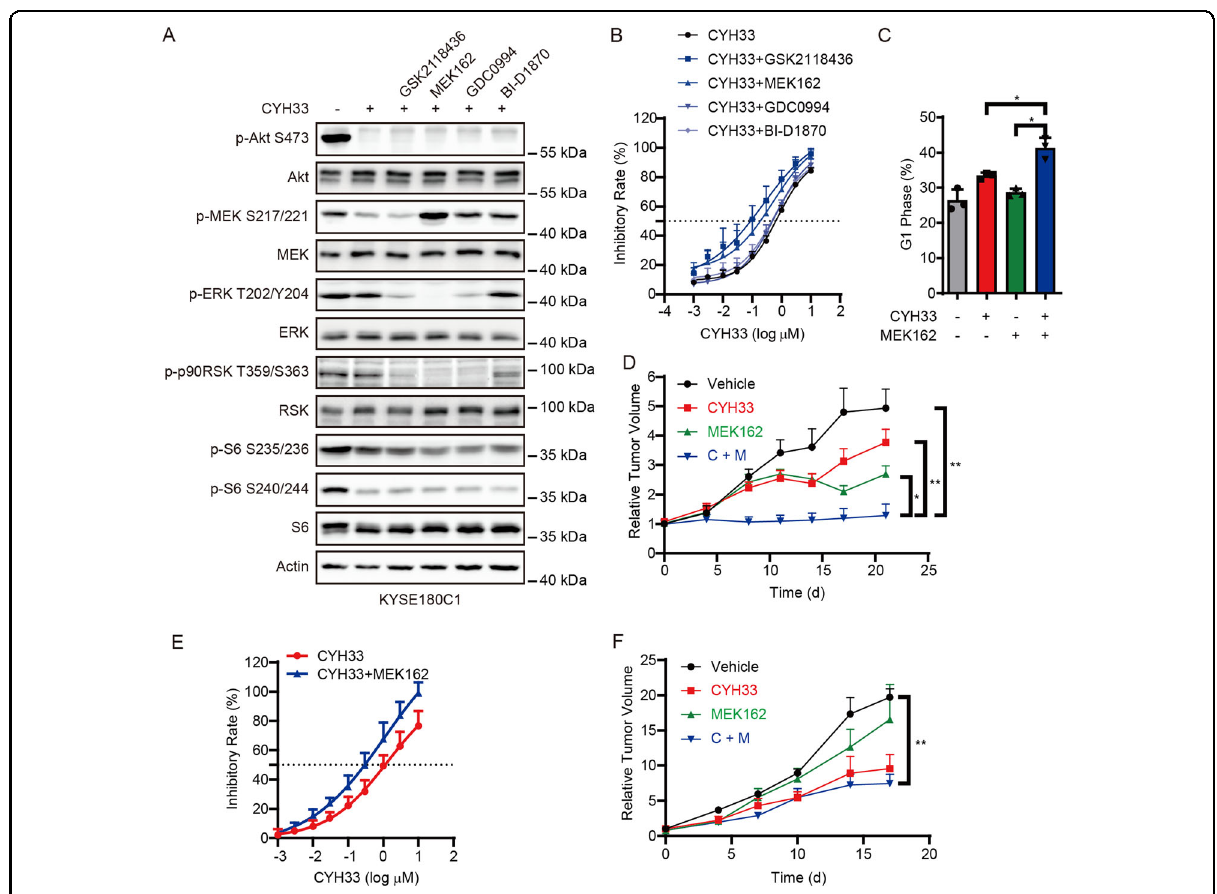
Fig. 5 Inhibition of MAPK signaling pathway sensitized KYSE180C cells to CYH33. A KYSE180C1 cells were treated with 1 μ M CYH33 alone or in combination with 1 μ M GSK2118436/MEK162/GDC0994/BI-D1870 for 1 h. Cell lysates were subjected to western blotting with indicated antibodies. B KYSE180C1 cells were treated with serially diluted CYH33 alone or concurrently with 1 μ M GSK2118436/MEK162/GDC0994/BI-D1870 for 72 h. Cell proliferation was measured with SRB assay. Data were presented as mean + SD ( n = 3). C KYSE180C1 cells were treated with CYH33 (1 μ M) and MEK162 (1 μ M) alone or concurrently and cell cycle distribution was analyzed by fl ow cytometry. Percentage of cell population in G1 phase was presented as mean + SD ( n = 3). Differences between the indicated groups were analyzed using one-way ANOVA with Tukey multiple group comparison test. * P < 0.05. D Randomly grouped nude mice bearing KYSE180C1 xenografts were administrated orally with a vehicle control, CYH33 (10 mg/kg), MEK162 (5 mg/kg), or a combination of CYH33 and MEK162 once a day for 21 days ( n = 6). Tumor volume was measured twice a week. Data were presented as mean + SEM. Differences between the indicated groups were analyzed using one-way ANOVA with Tukey multiple group comparison test. ** P < 0.01. E KYSE180-H cells were treated with serially diluted CYH33 alone or concurrently with 1 μ M MEK162 for 72 h. Cell proliferation was measured with SRB assay. Data were presented as mean + SD ( n = 3). F Randomly grouped nude mice bearing